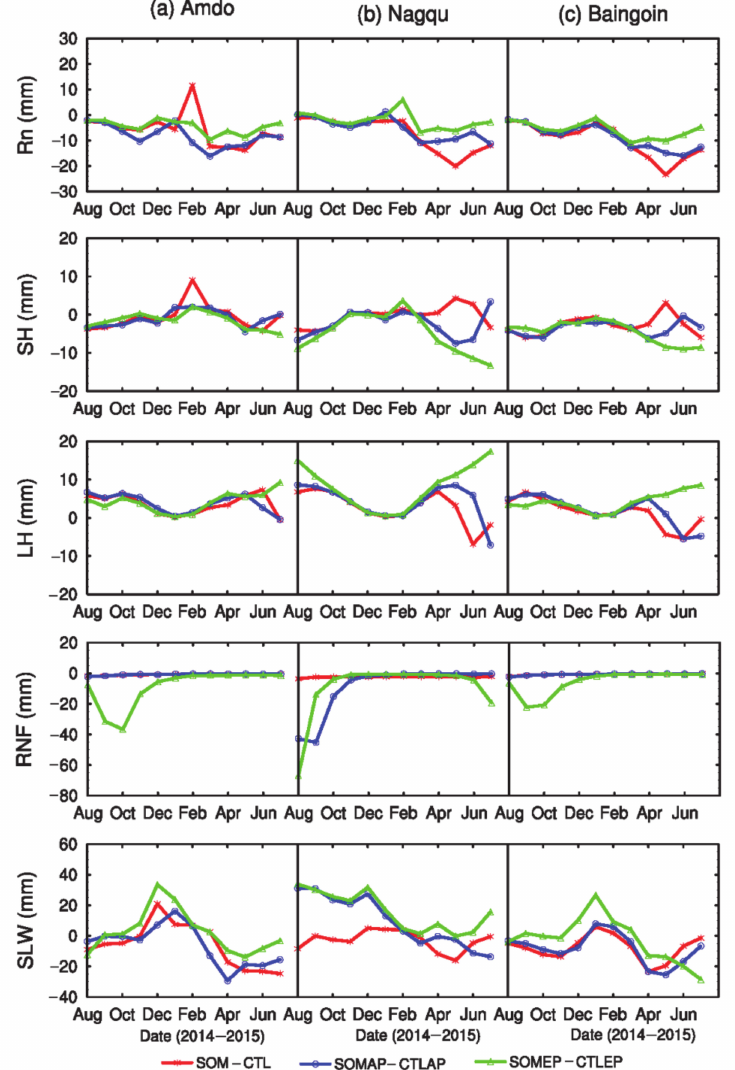
Figure 12. The monthly di ff erences in simulated hydrological cycles for selected optimal scheme combinations resulted from soil organic matter at the ( a ) Amdo site, ( b ) Nagqu site, and ( c ) Baingoin site; subfigures from top to bottom show the monthly di ff erences in Rn, SH, LH, RNF, and 0–1 m total SLW,